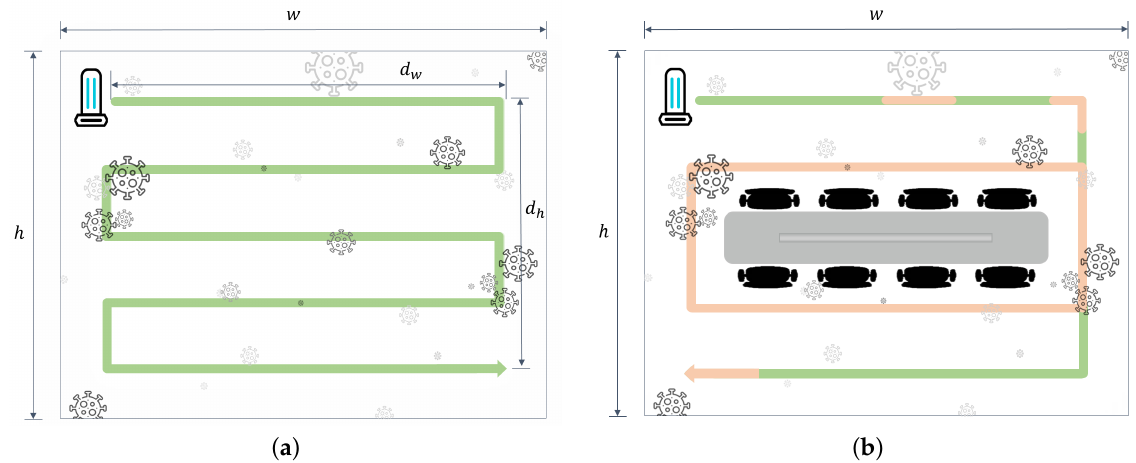
Figure 8. Illustration of a virtual conference room with a width and height of w and h , respectively. In the case of ( a ), an empty conference room and ( b ) a general conference room, the expected paths of the UVD robot are correspondingly indicated by the green and pink lines. The green lines denote the path moving at a speed of 0.13 m/s, and the pink lines are the path requiring intensive